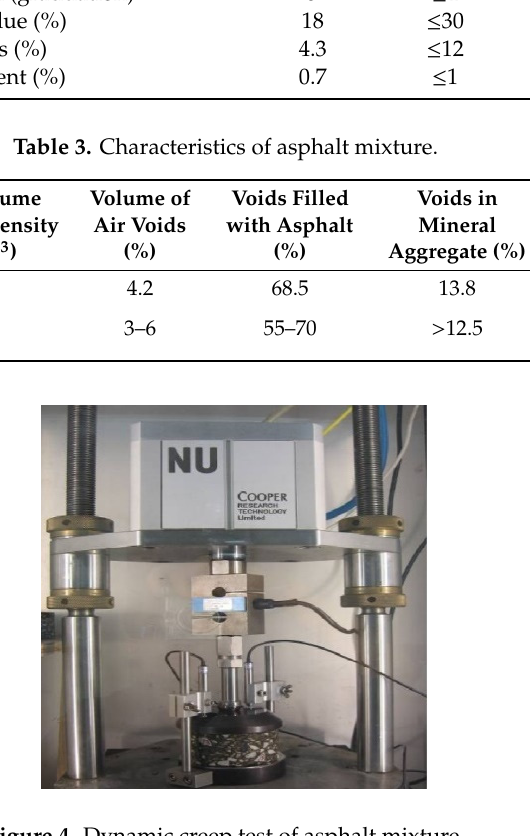
Table 3. Characteristics of asphalt mixture.